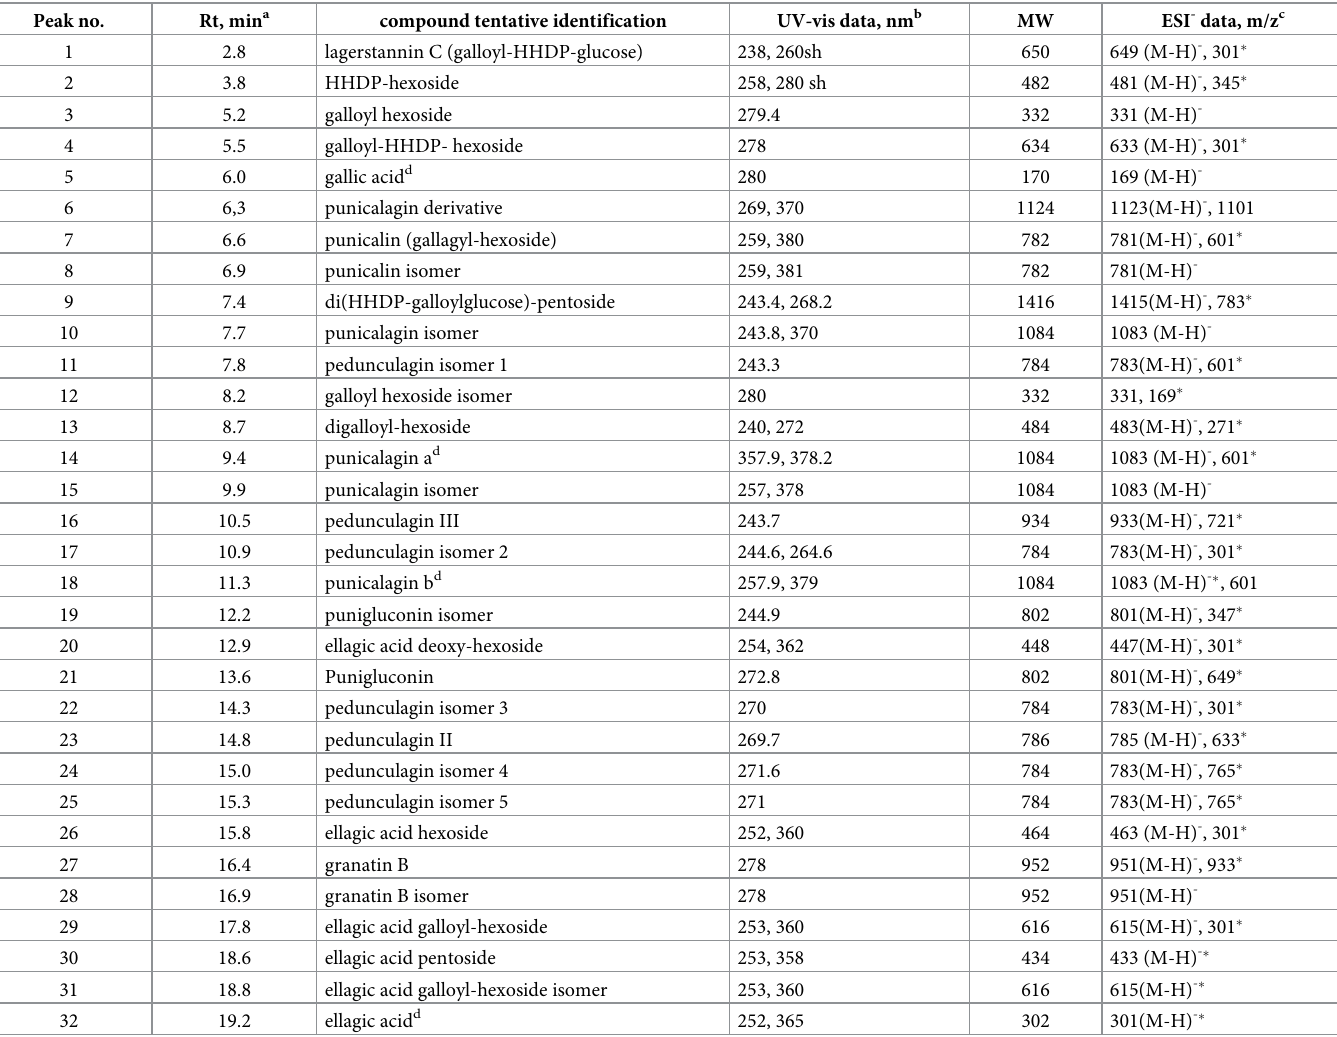
Table 1. Peak list and diagnostics of selected metabolites from pomegranate matrices object of this study. Peak